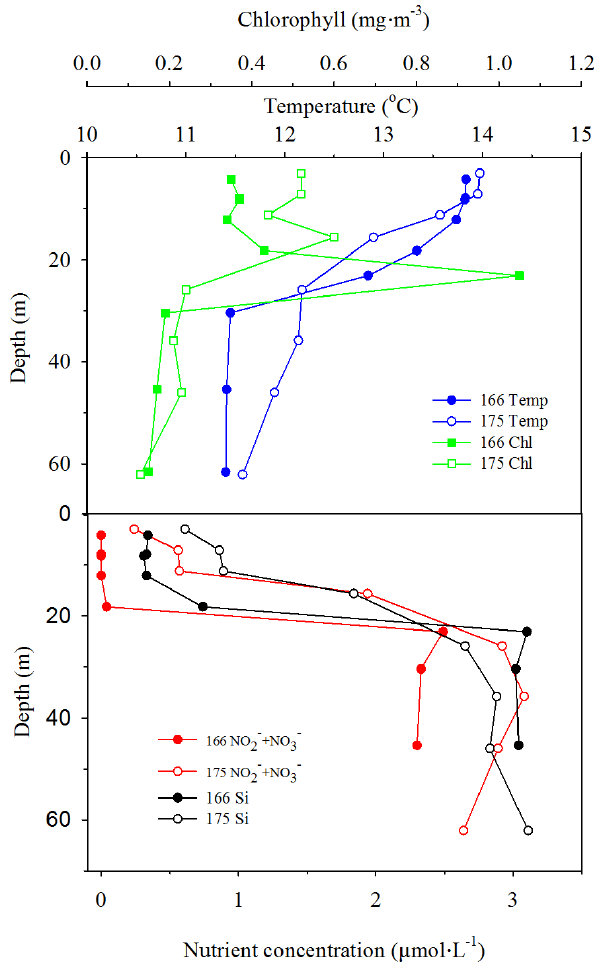
Figure 7. Water column profiles for Western Channel Observatory time series station E1 for Julian days 166 and